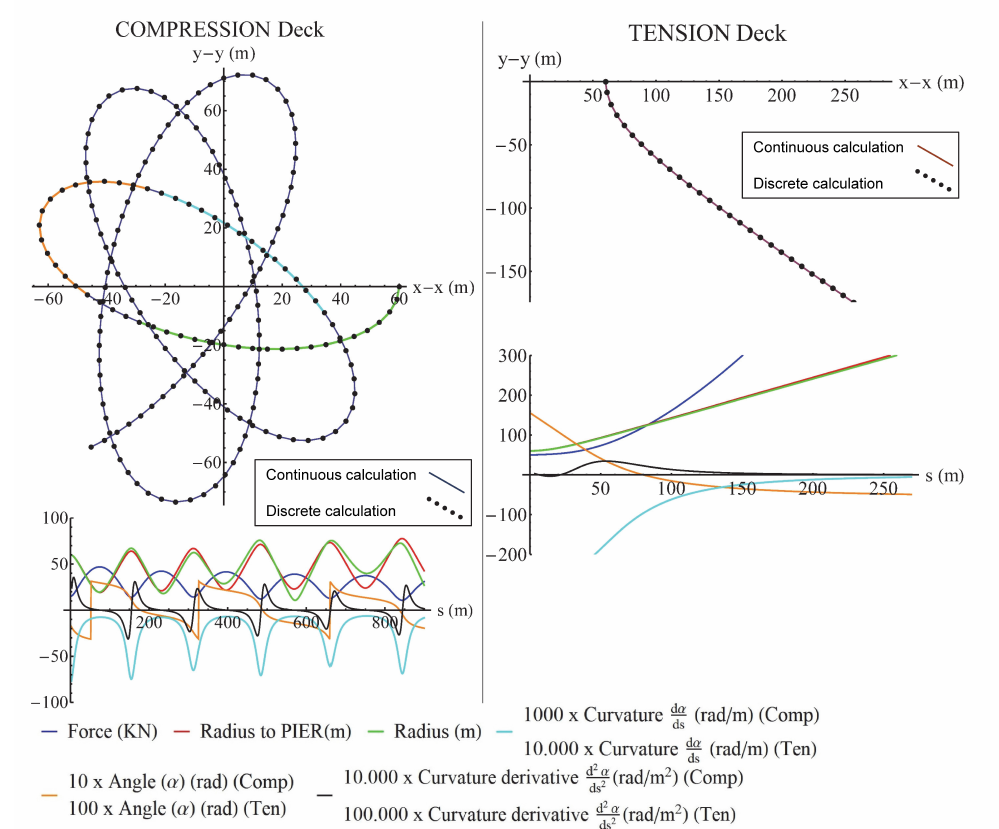
Figure 2: Compression (anti funicular) and Tension (funicular) decks. Discrete and continuous calculations.